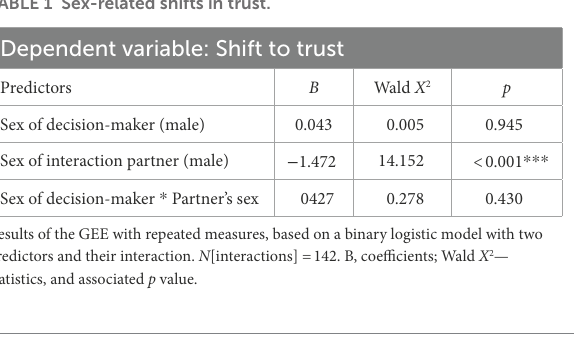
TABLE 1 Sex-related shifts in